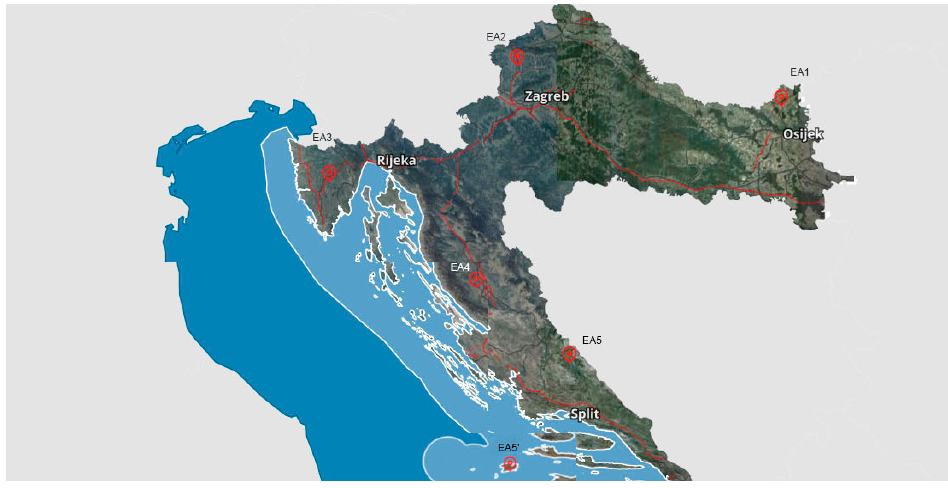
Figure 1. Locations of experimental apiaries in Croatia.